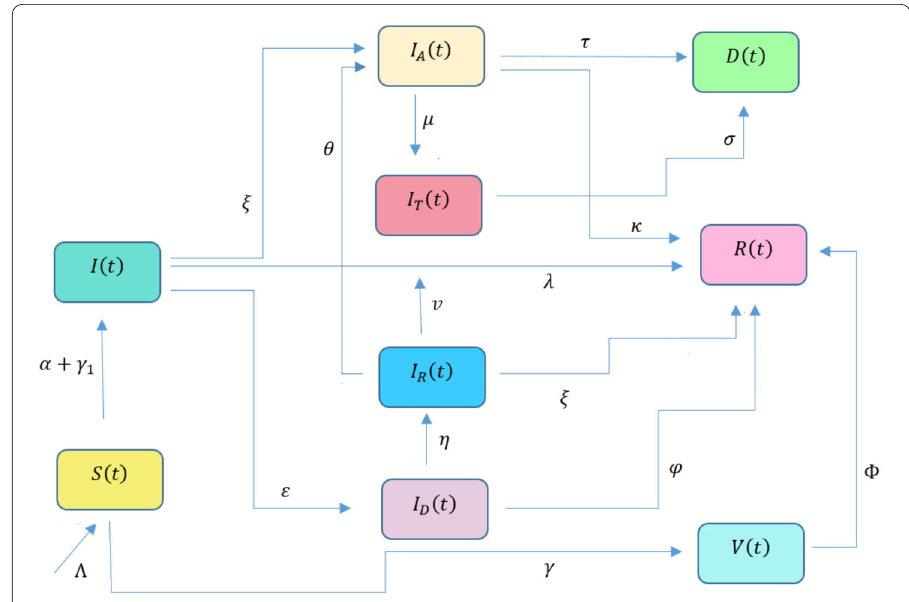
Figure 32 Diagram summarizing Covid-19 model given by the suggested